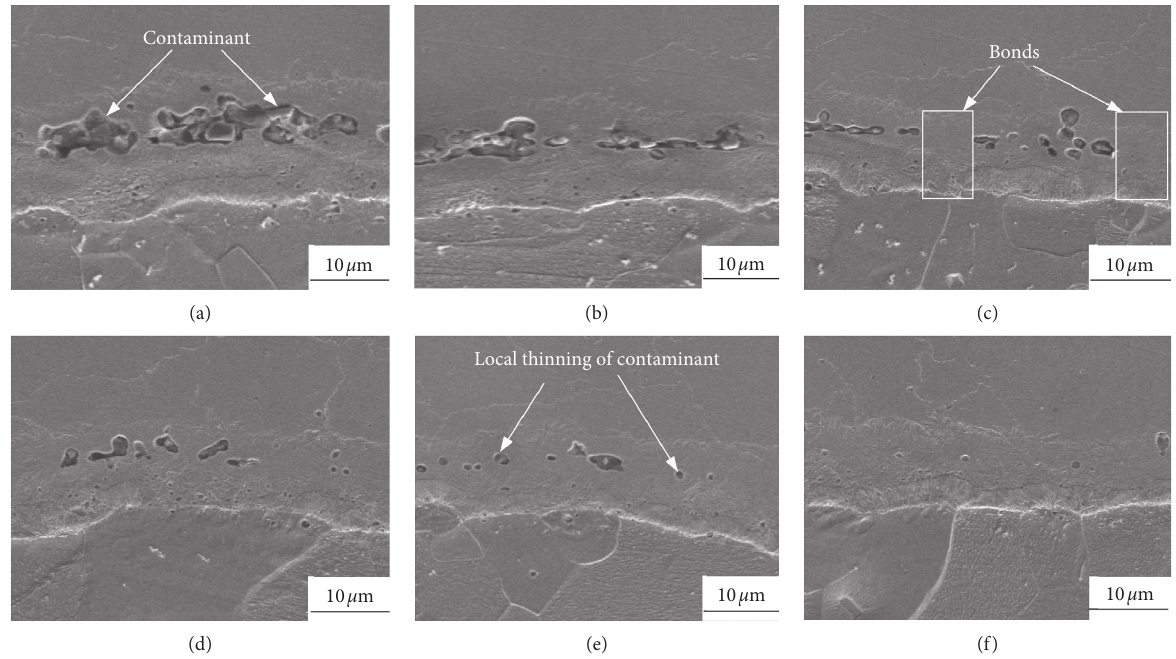
Figure 15: The SEM morphology of bonding layer at different reduction rates (1000x). (a) 20% reduction rate. (b) 30% reduction rate. (c) 40% reduction rate. (d) 50% reduction rate. (e) 60% reduction rate. (f) 70% reduction